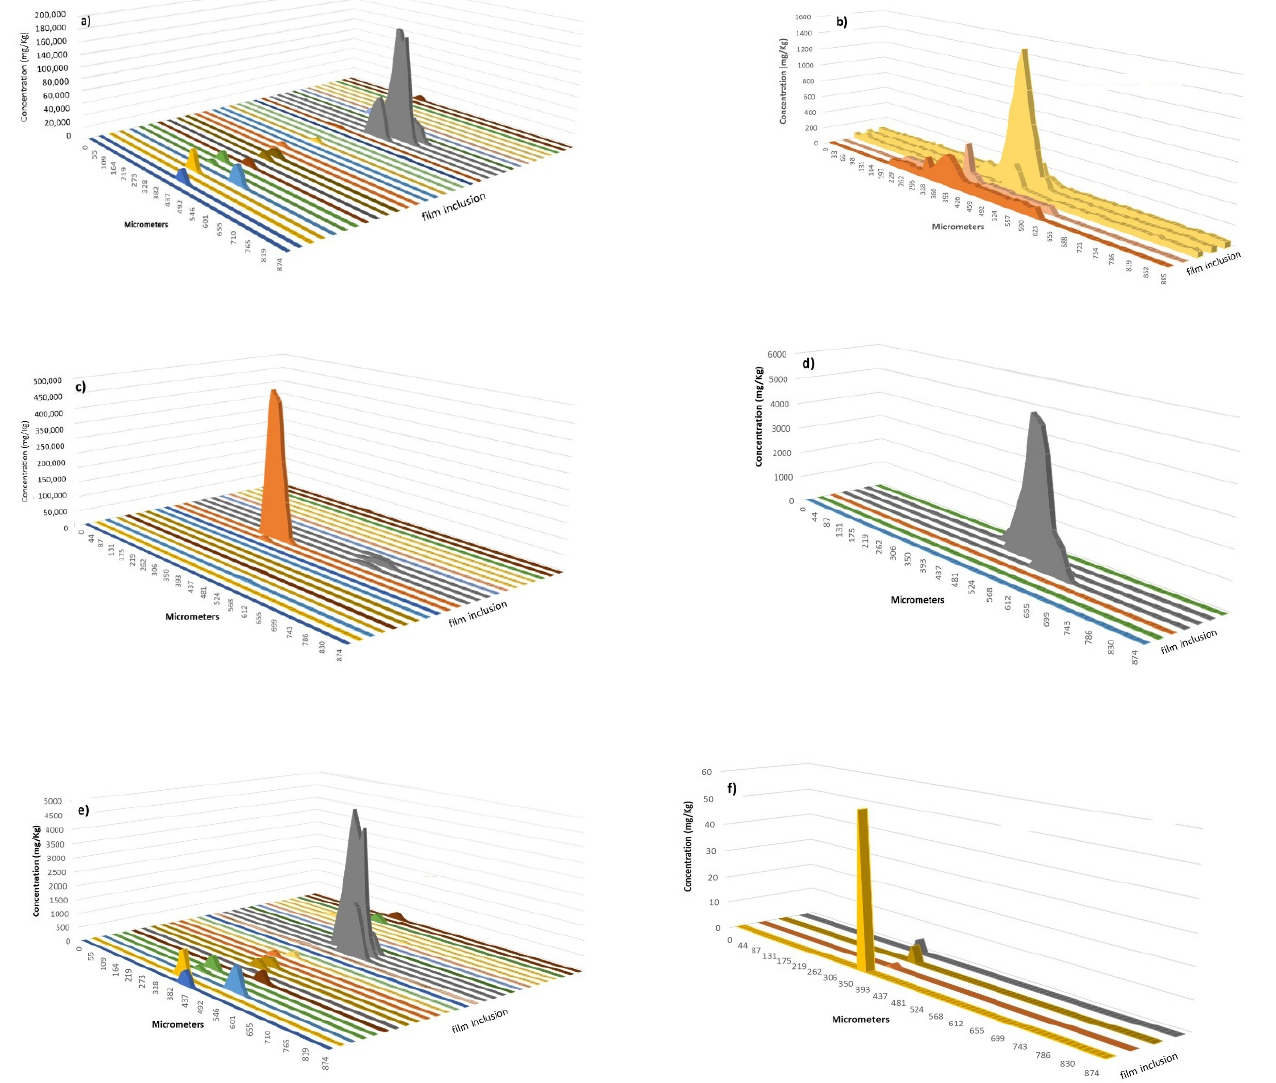
Figure 7. Concentration profiles of ( a ) Al, ( b ) Mg, ( c ) Ti, ( d ) Cr, ( e ) Zr, and ( f ) Pb along the scan line used to ablate the defects in the film #2. Only the inclusions yielding ICP-MS signals for the monitored elements are included.